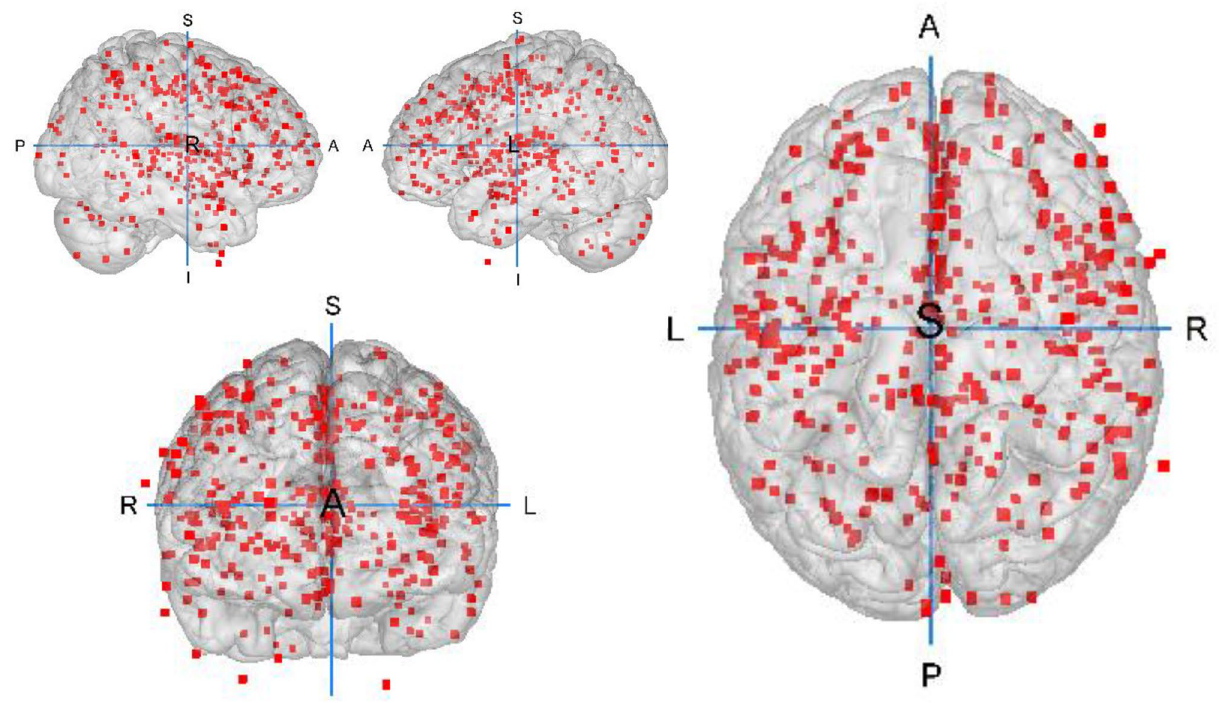
Figure 2. Foci-distribution of the experiments included in the ALE meta-analysis. Foci are depicted on a grey matter glass brain. Red Blobs: Foci; A: anterior; S: superior; P: posterior; L: left; R: right. This image was created with Mango v4.1. (http://ric.uthsc sa.edu/mango